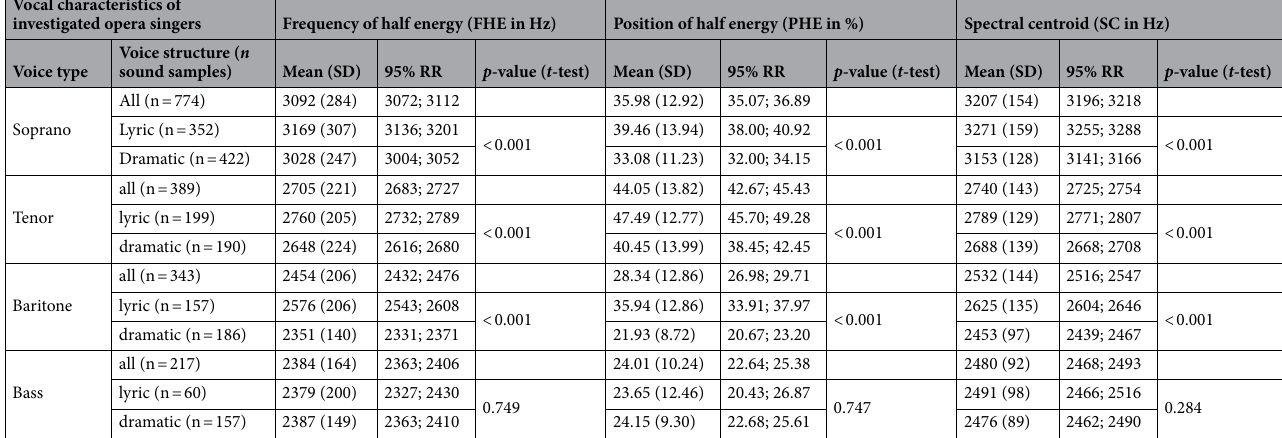
Table 2. Individual results of the investigated timbre and vibrato parameters for the elite vocal performers Plácido Domingo, Mario Cassi, Birgit Nilsson, Nina Stemme and Daniela Mazzucato. For easier comparison, the 95% reference ranges represent the data of all investigated singers of the corresponding voice type and voice structure (lyric vs. dramatic), taken from Table 1 (FHE, PHE, SC) and Müller et al. 17 (VR, VE). B2 lyric baritone, FHE Frequency of Half Energy, PHE Position of Half Energy, RR reference ranges (lower bound; upper bound), S1 dramatic soprano, S2 lyric soprano, Sample size number of investigated sound samples, SC spectral centroid, SD standard deviation, T1 dramatic tenor, VE vibrato extent, VR vibrato